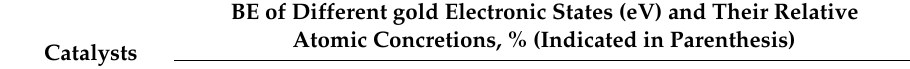
Table 2. Binding energy and relative atomic concentrations of various silver electronic states in catalysts.